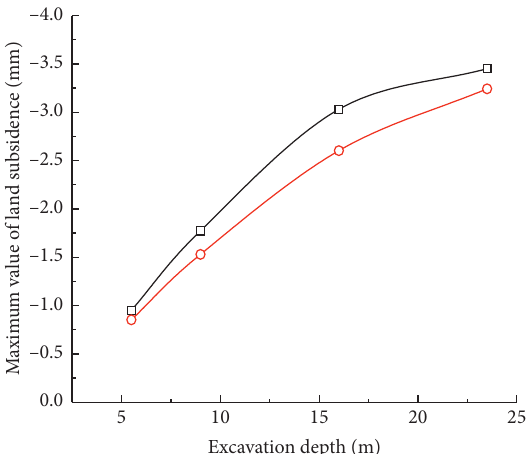
Figure 3: Ground settlement outside the pit under various working